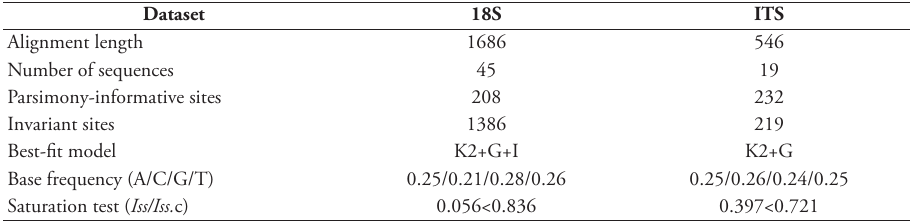
Table 1. Detailed information of alignment and nucleotide substitution in 18S and tuf A concatenated phylogenetic for ML